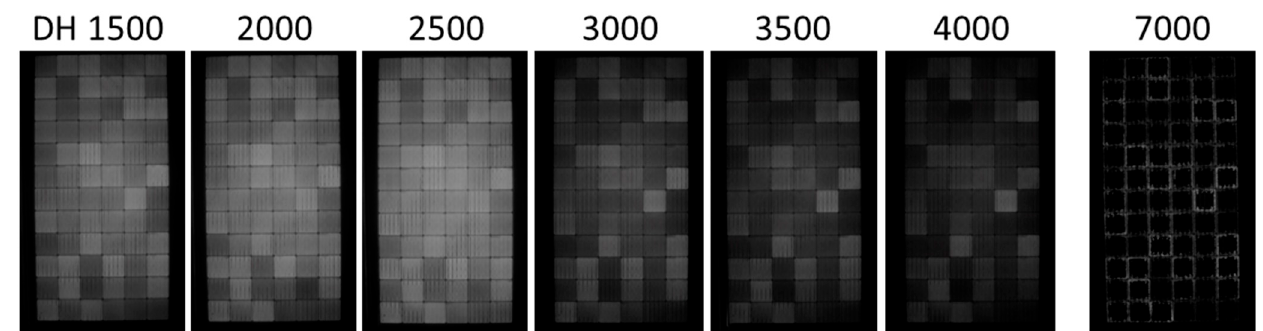
Figure 4. Electroluminescence images of modules with respect to damp heat test times.